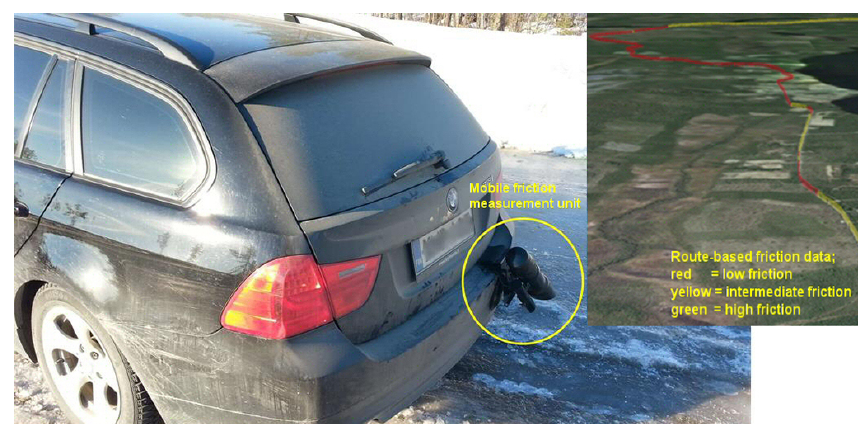
Figure 6. Teconer friction measurement instrument mounted onto the vehicle.